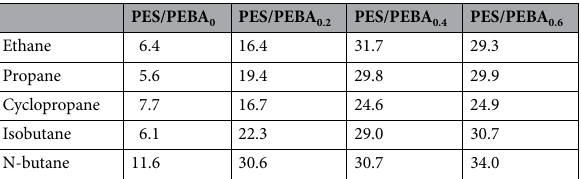
Table 1. The separation coefficients of different gases tested by membranes with different fumed silica contents.